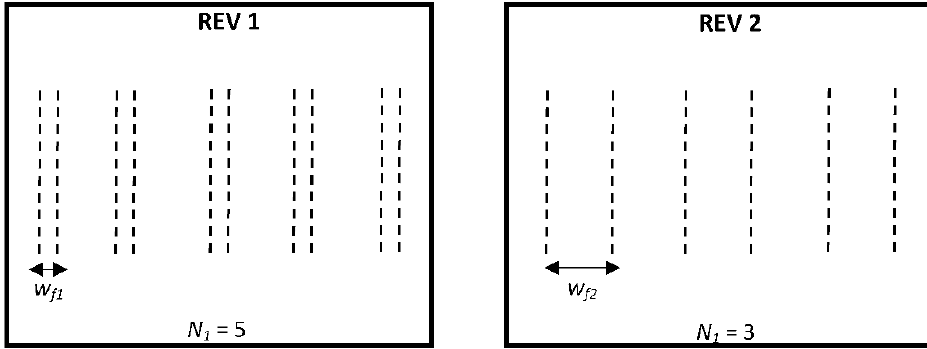
Figure A2. Permeability tensor components for multiple fracture ( a ) parallel and ( b ) oblique to far-field flow (modified from Weijermars and Khanal, [23]). v y is the average velocity in the y direction while v x is the average velocity in the x direction. The variable v y _ f f gives the velocity if the far field flow into the REV model.